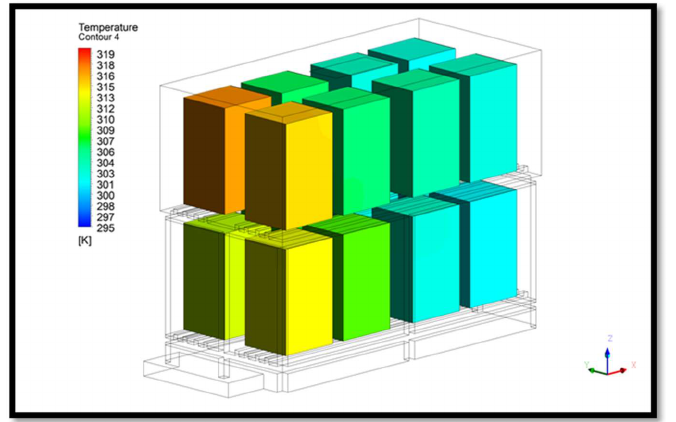
Figure 17. Default model battery temperatures resulting from simulation.